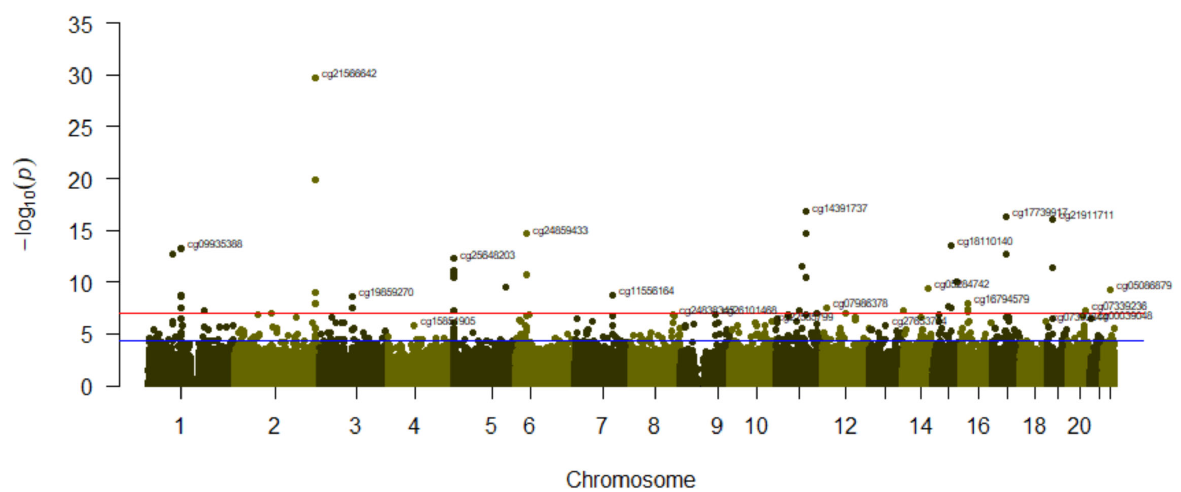
Figure 4. Manhattan plot of the epigenome-wide association among never smokers relative to current smokers (multivariate adjusted). Red line represents the EWAS significance level p = 9 × 10 − 8 . The blue line represents p = 1 × 10 − 5 . The GRCh37/hg19 assembly has been used. Part A of Table 3 ranks the 15 most differentially methylated CpG sites according to their p ‐ value for the categorical variable tobacco smoking (3 categories). Table S3 presents